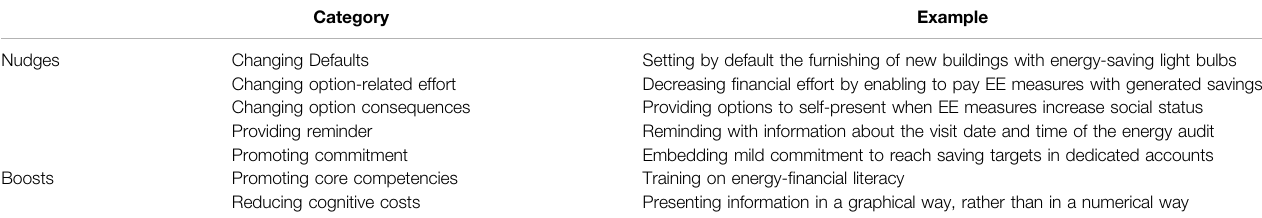
TABLE 3 | “ Summary of nudges and boosts promoting EE ”